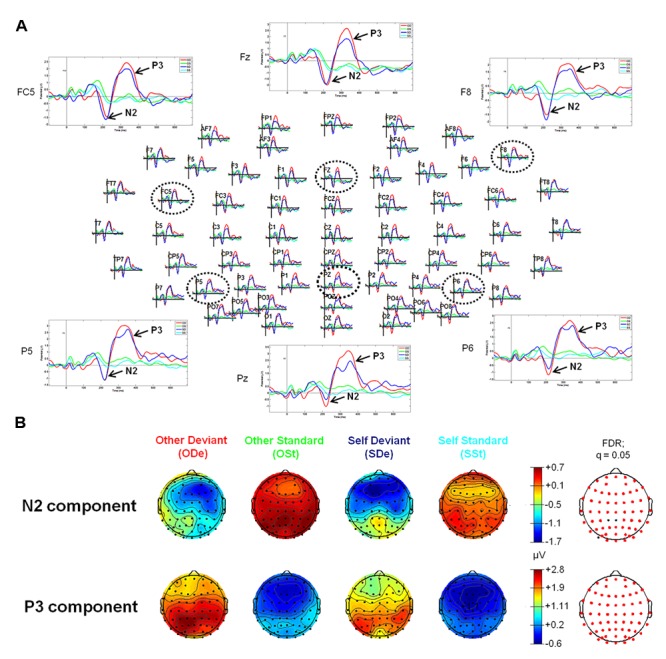
Event-related potentials (upper panel, A) and topographic plots (lower panel, B) for the N2 and P3 components in all four experimental conditions of the “Self-Other” oddball paradigm. (A) The head plot shows ERP waveforms from 62 electrode sites. Three anterior electrode sites (FC5, Fz, and F8) as well as three posterior electrodes (P5, Pz, and P6) are shown in detail (as indicated by black dashed circles). ERP waveform plots reveal the N2-P3 complex. Higher amplitudes of the N2 component can be observed at anterior sides, whereas the P3 shows higher amplitudes at posterior electrode sites (especially in condition “ODe”). (B) Reddish colors indicate positive ERP values, whereas bluish colors indicate negative ERP values. Moreover, transparent EEG montage arrays (lower panel B) show statistically significant electrode sites as indicated by red dots (after comparison for multiple comparisons with FDR). FDR, False discovery rate.